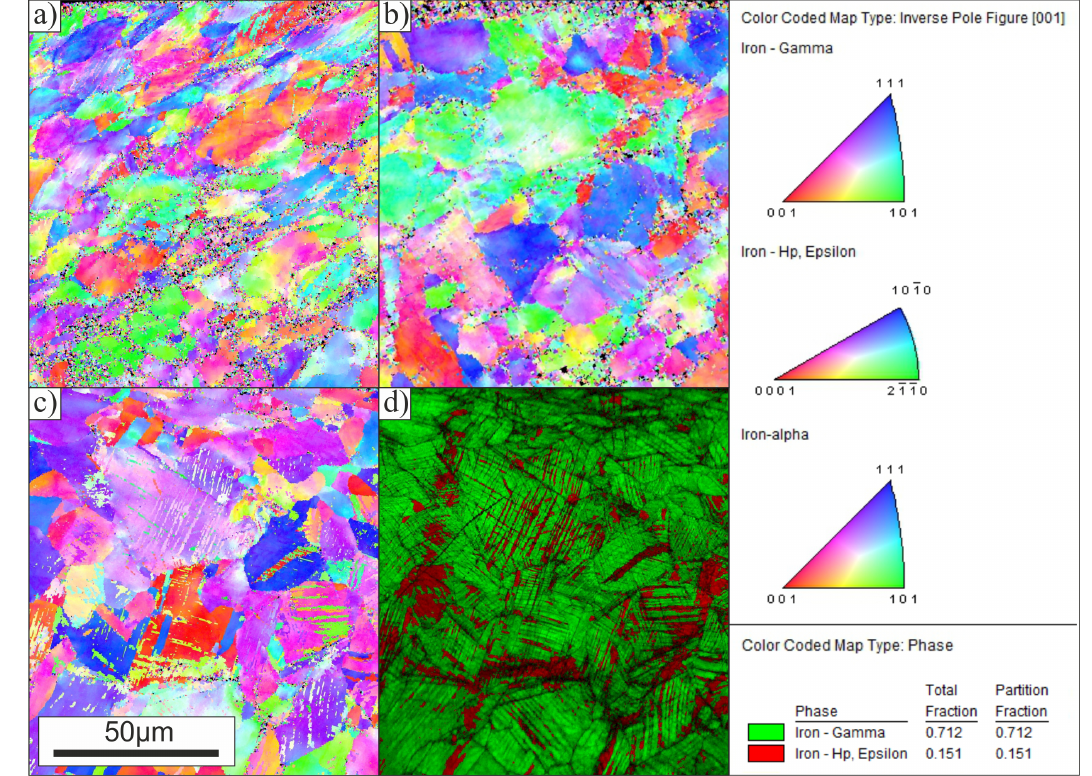
Figure 6. IPF maps ( a – c ) and phase map with superimposed image quality (IQ) ( d ) for differently treated specimens. IPF maps depict the near surface microstructure following deep rolling at room temperature ( a ), 200 ◦ C ( b ) and cryogenic temperature ( c ) using a deep rolling force of 855N. The IQ-phase map for a surface layer after deep rolling at cryogenic temperature is shown in ( d ). What appears to be twinning in the IPF map clearly is resolved as a γ → (cid:101) phase transformation in ( d ). Color coding in ( a – d ) is in accordance to the standard triangles and the nomenclature shown to the